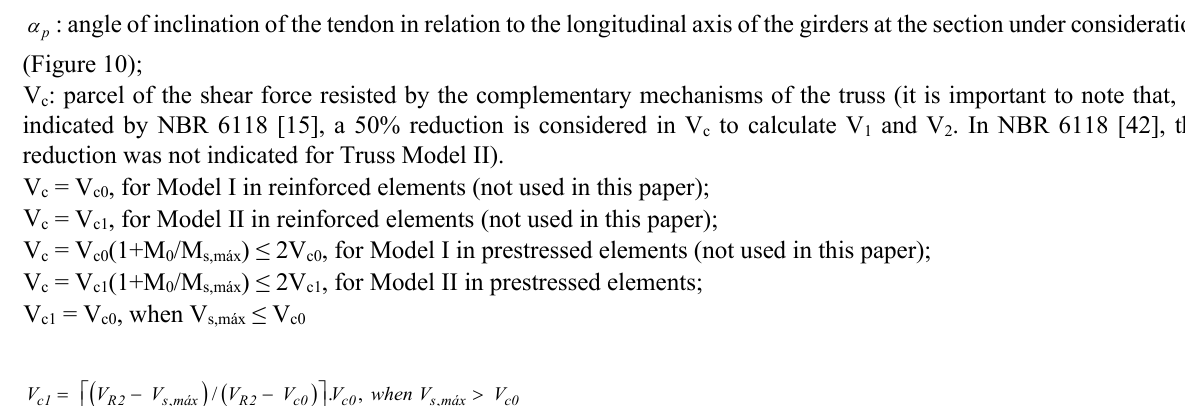
reduction was not indicated for Truss Model